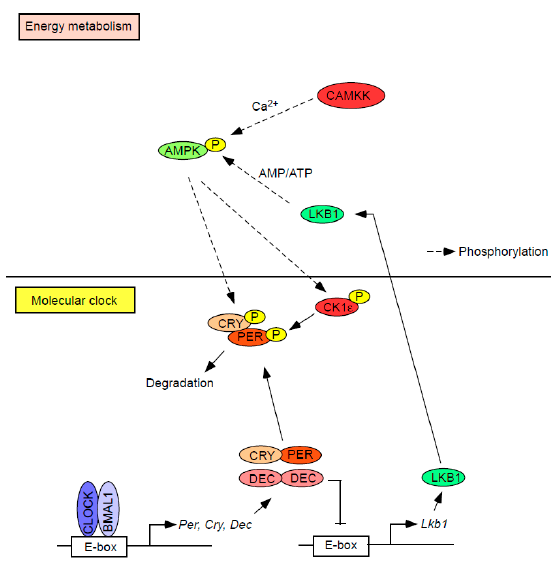
Figure 3. Interplay between the regulation of bioenergy and the molecular clock. Activated AMPK directly or indirectly phosphorylates core circadian repressors (i.e., PER/CRY). DEC, another circadian repressor, suppresses the transcription of Lkb1 which codes for a serine-threonine kinase that directly phosphorylates and activates AMPK, thus forming a reciprocal relationship between regulators of bioenergy and the circadian clock.